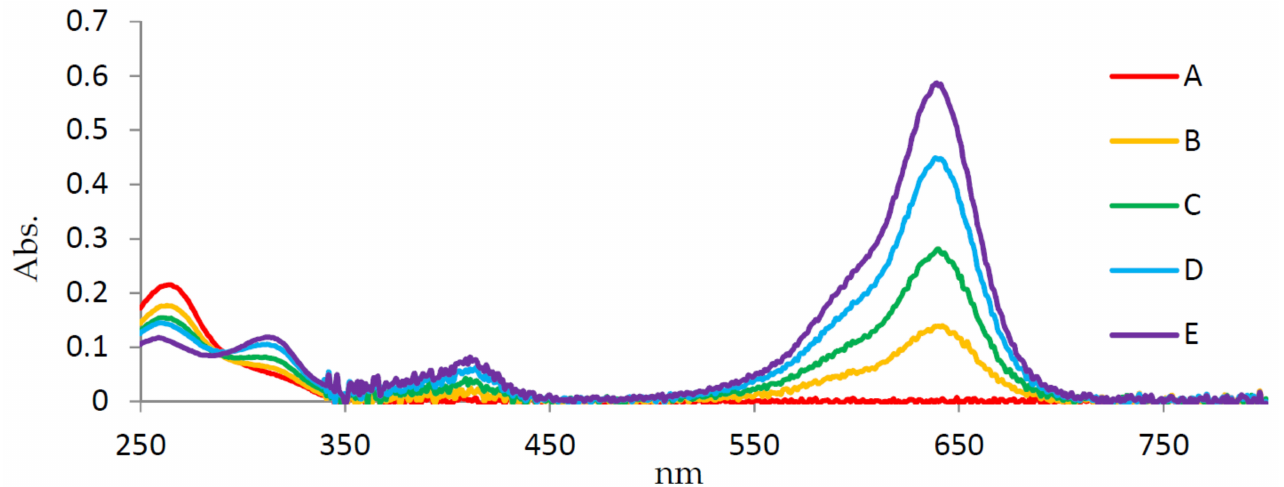
Figure 1. Ultraviolet–visible spectra of leuco acid (5), Acid Blue 7 (6), and mixtures. Concentrations of mixtures of leuco acid and Acid Blue 7 (leuco acid:Acid Blue 7, 10 − 5 M) are as follows: A = 1.0:0; B = 0.75:0.25; C = 0.5:0.5; D = 0.25:0.75; E =